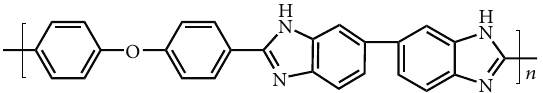
Figure 1: The molecular structure of poly (4,4 ′ -(diphenyl ether)- 5,5 ′ -bibenzimidazole)